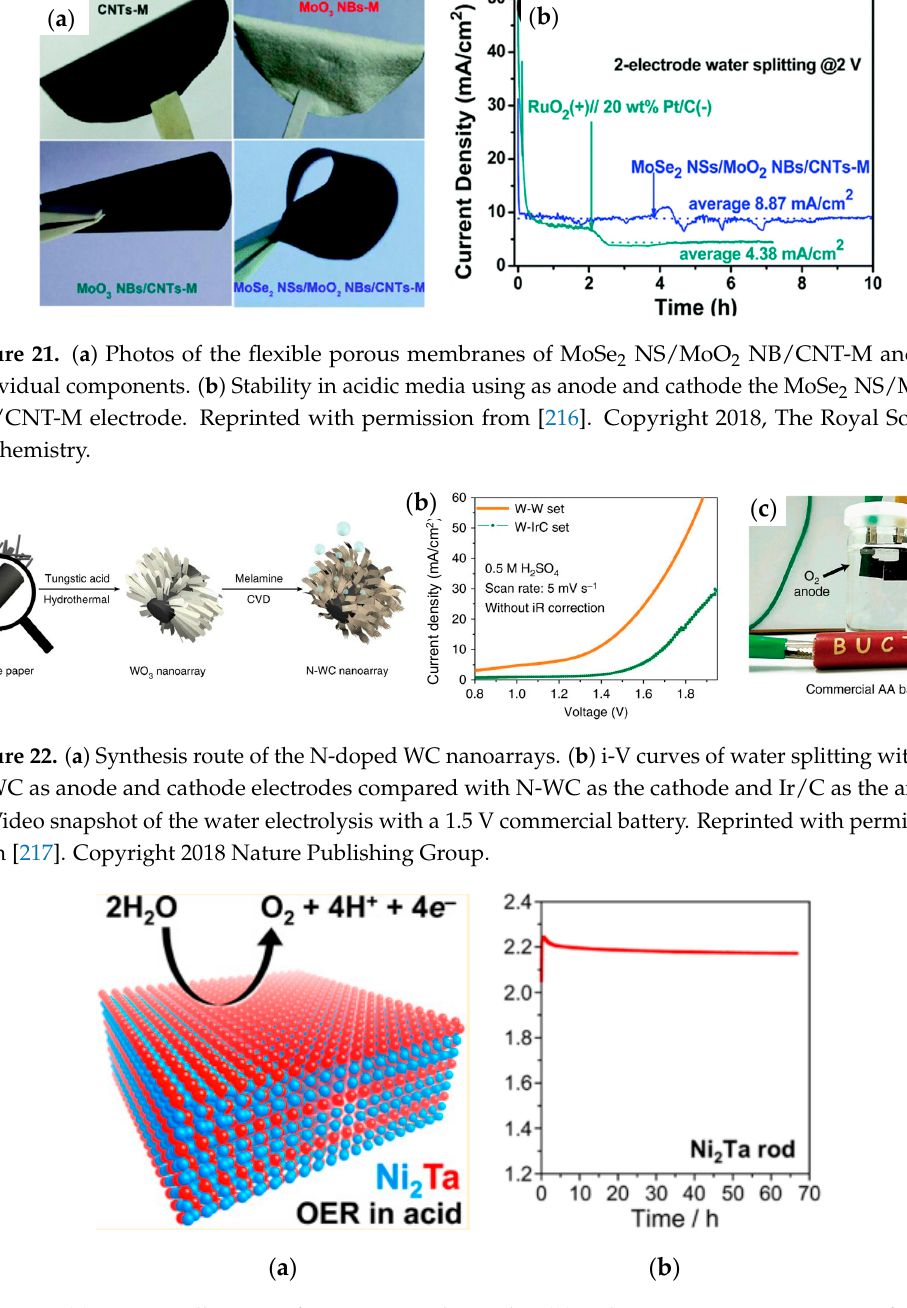
Figure 23. ( a ) Intermetallic Ni 2 Ta for OER in acidic media. ( b ) Galvanostatic measurements of Ni 2 Ta rods in 0.5 M H 2 SO 4 at 10 mA/cm 2 . Reprinted with permission from [218]. Copyright 2018 American Chemical Society.